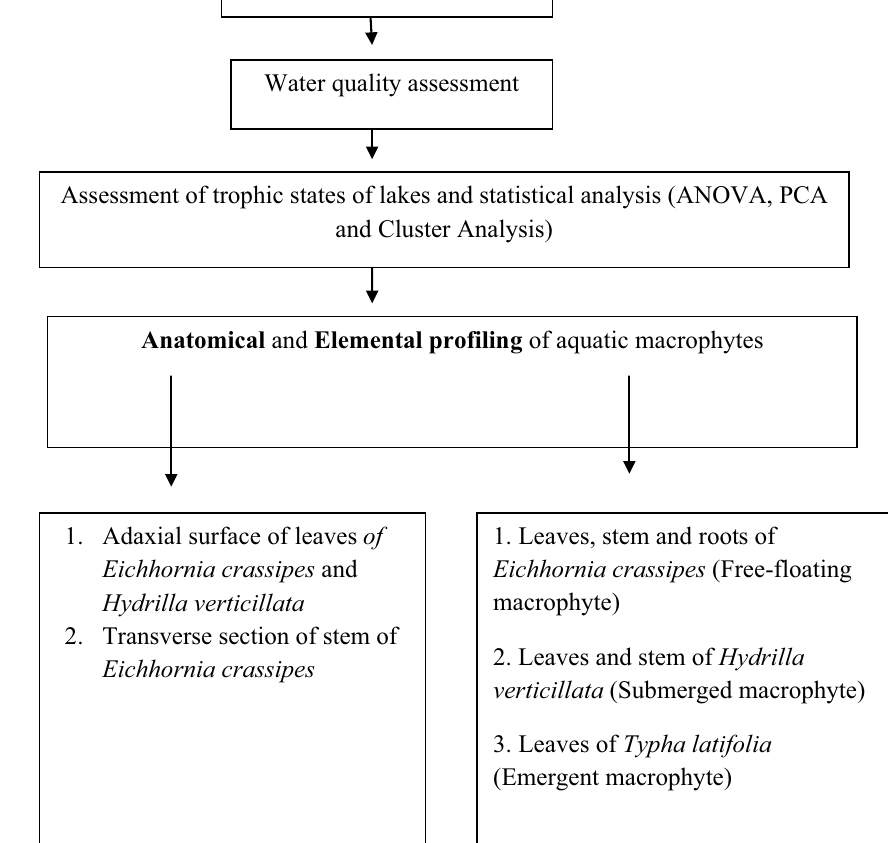
Fig. 1 Flowchart depicting study design and